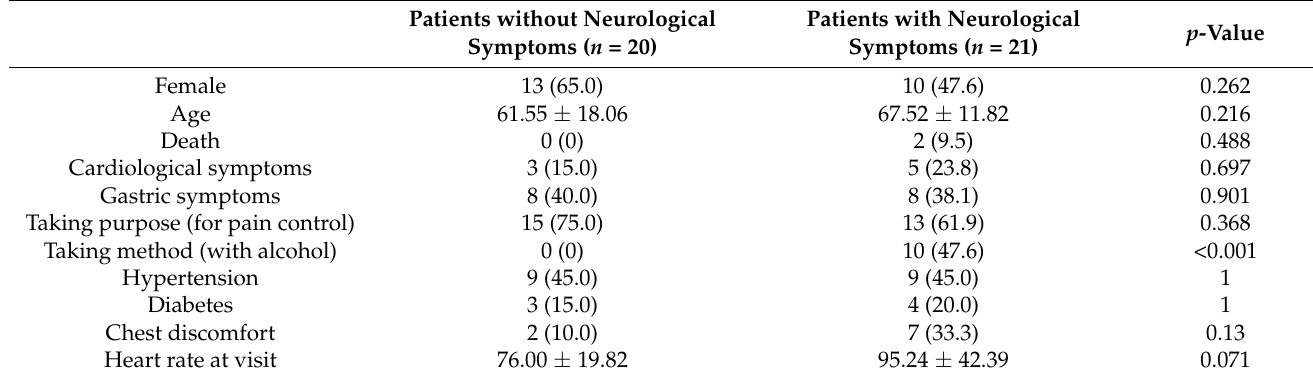
Table 4. Factors associated with neurological